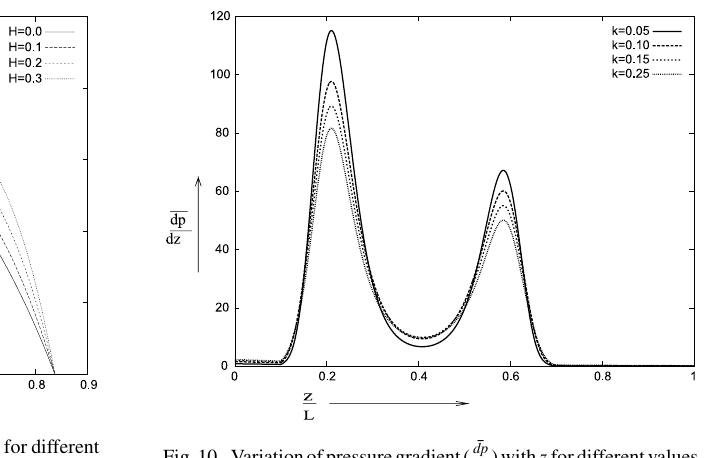
Fig. 8. Variation of axial velocity in the radial direction for different values of H at z = 2 . 0, when M = 2 . 5, β = 2 . 5, α = 0 . 09 and k = 0 . 25.